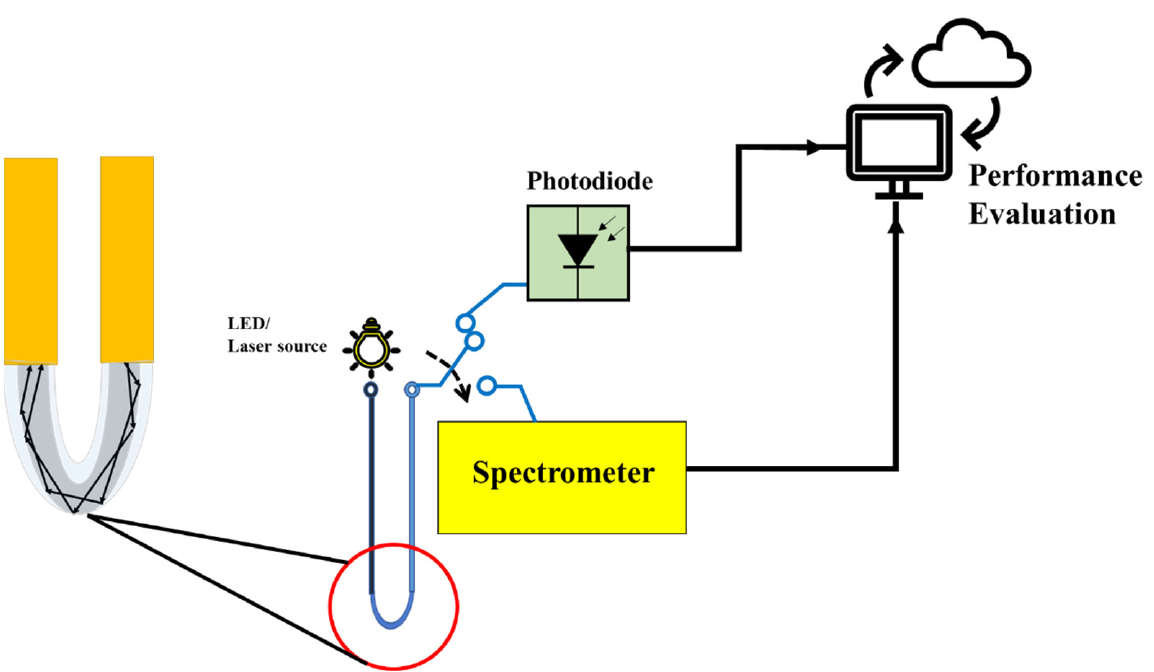
Figure 5. Schematic diagram of U-shaped optical fiber probe connected on one side with LED laser source and other probe with the photodiode or spectrometer. The performance is then evaluated.